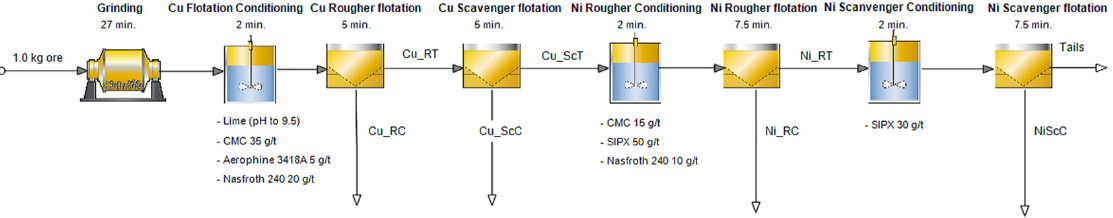
Figure 3. Laboratory flotation test flowsheet. The abbreviations for the test products shown in the flowsheet are Cu_RC: copper rougher concentrate, Cu_RT: copper rougher tailings, Cu_ScC: copper scavenger concentrate, Cu_ScT: copper scavenger tailings, Ni_RC: nickel rougher concentrate, Ni_RT: nickel rougher tailings and NiScC: nickel scavenger concentrate.